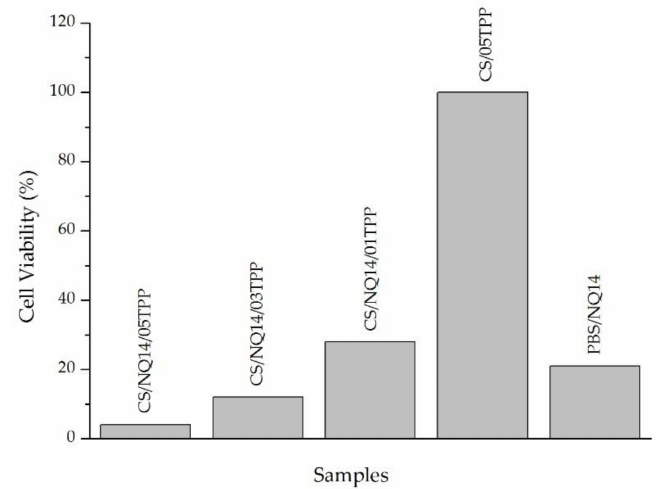
Figure 9. Effect of 1,4-naphthoquinone (NQ14) on the proliferative growth of B16F10 melanoma cell line determined by MTT assay. Membranes loaded with NQ14 (CS/NQ14/05TPP, CS/NQ14/03TPP and CS/NQ14/01TPP), control (membrane without drug-CS/05TPP) and phosphate buffered saline (PBS)/NQ14